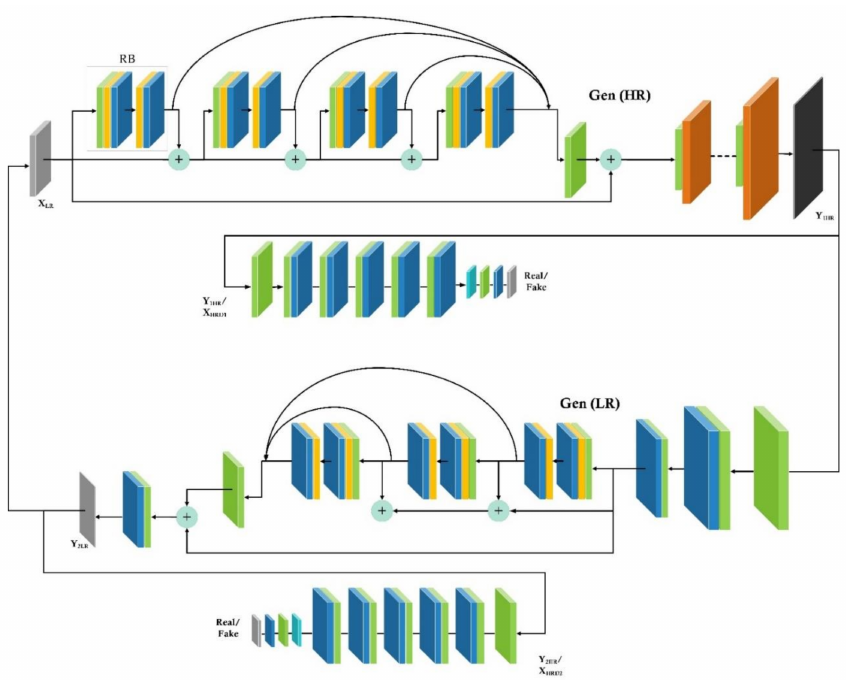
Figure 7. The cyclic approach: GAN-EDSR-RFA. Gen (HR) and its discriminator is shown on top, and Gen (LR) for cyclic feedback is shown in the lower half of the